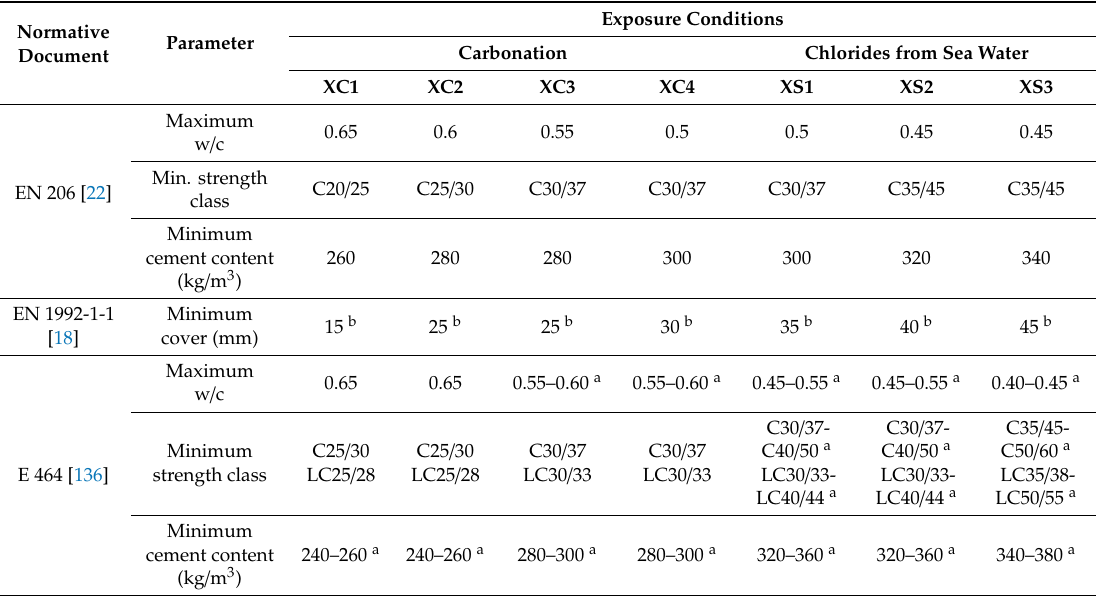
Table 3. Composition limits prescribed by various normative documents for a service life of 50